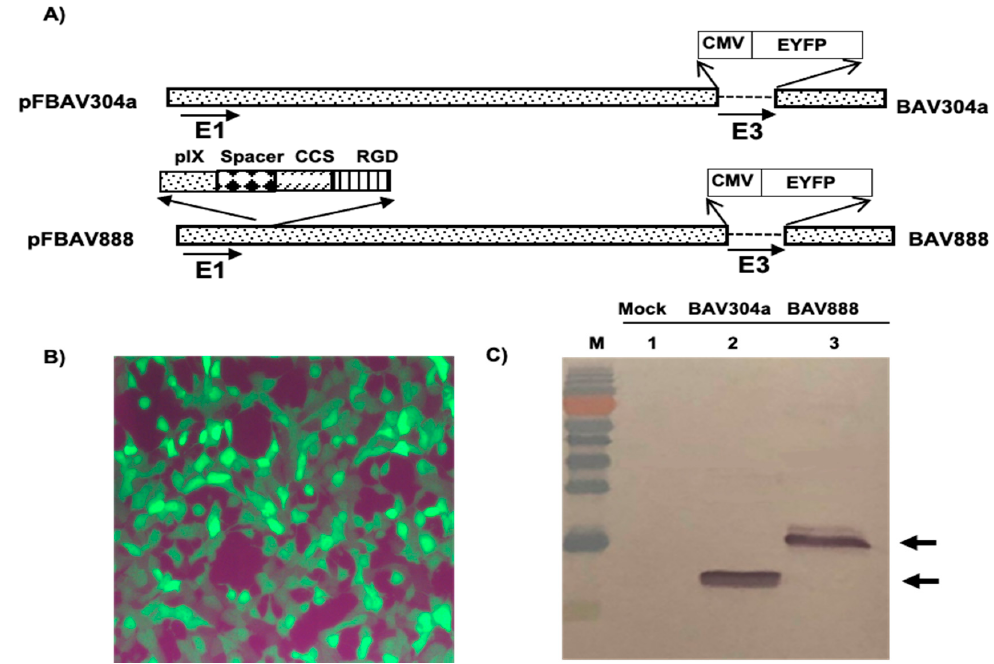
Figure 5. Construction and characterization of BAV888. ( A ) Schematic diagram of BAV304a and BAV888 genomes; cathepsin cleavage site (CCS); 10 repeats of glycine-serine (spacer), RGD amino acids (RGD). The shaded box represents the BAdV-3 genome sequence, while the dashed line in early (E)-3 region represents deletion in this region. Human cytomegalovirus immediate early gene promoter (CMV); enhanced yellow fluorescent protein (EYFP) gene. The direction of transcription is indicated with arrows. The name of each plasmid is indicated to the left and virus name is indicated to the right. ( B ) EYFP fluorescence. The cells were infected with BAV888 and analyzed by Leica TC5 SP5 immunofluorescence microscope (Magnification 400×) . ( C ) Expression of pIX in BAV304a and BAV888 infected cells. The proteins from the lysates of mock-infected cells (lane 1), BAV304a infected cells (lane 2) or BAV888 infected cells (lane 3) were separated with 15% SDS-PAGE, transferred to a nitrocellulose membrane and probed in Western blot using anti-pIX antiserum. The pIX protein is indicated by arrows. Molecular weight markers (M).